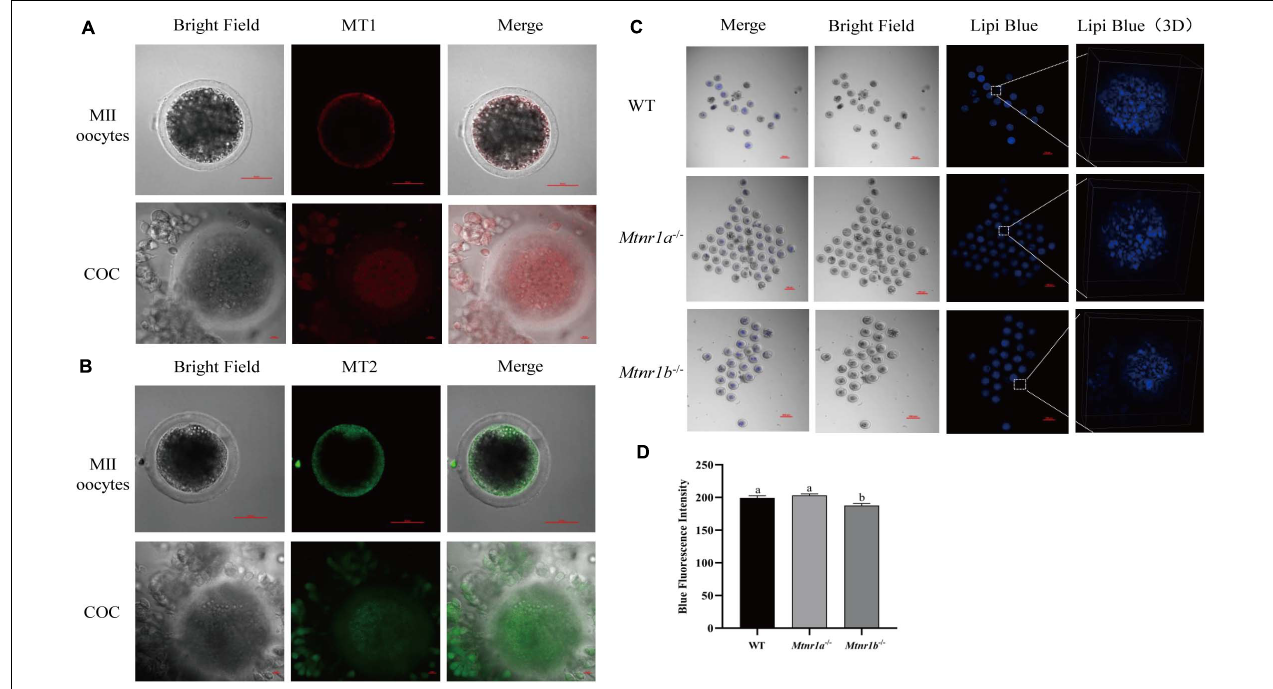
FIGURE 6 | Melatonin receptors express in porcine COCs and participate in the maintenance of lipid metabolism in mouse oocytes. (A) The percentage of blastocysts in porcine oocytes treated with control ( n = 400), luzindole ( n = 204), and luzindole + melatonin ( n = 203). (B) Representative images of immunofluorescence staining of melatonin receptor 1 (red) and melatonin receptor 2 (green) in porcine oocytes and COC. Scale bar: 100 µ m. (C) Representative images of Lipi-Blue fluorescence (blue) in C57/BL6 mice MII stage oocytes. Scale bar: 100 µ m. (D) Representative images of Lipi-Blue fluorescence in WT ( n = 19), Mtnr1a − / − ( n = 46), and Mtnr1b − / − ( n = 23) mice MII stage oocytes. Student’s t -test and one-way ANOVA were utilized for statistical analyses. Different lowercase letters indicate significant differences. Error bars indicate